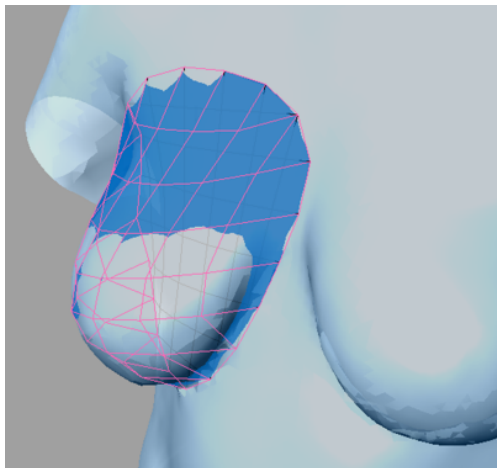
Figure 8. FDM-simulated unsupported breast compared to example